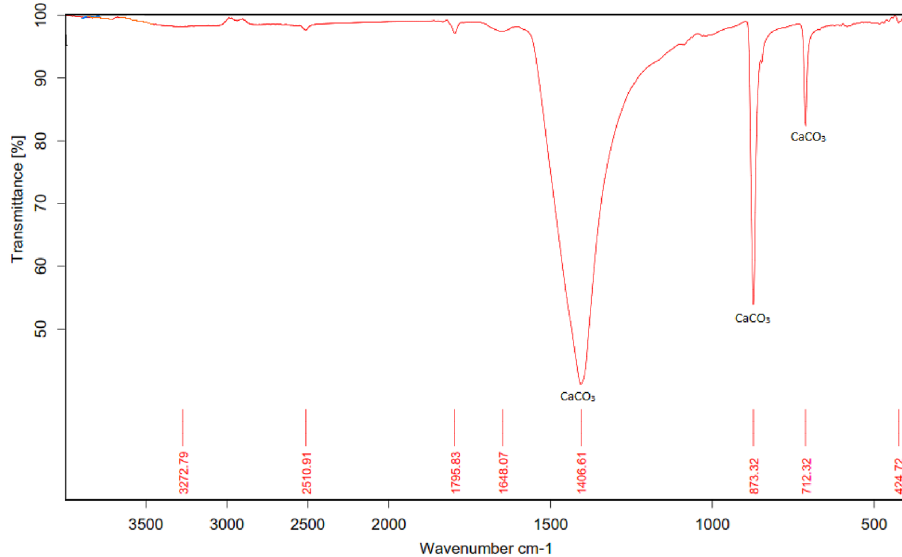
Fig. 2 FT-IR spectrum of egg- shell